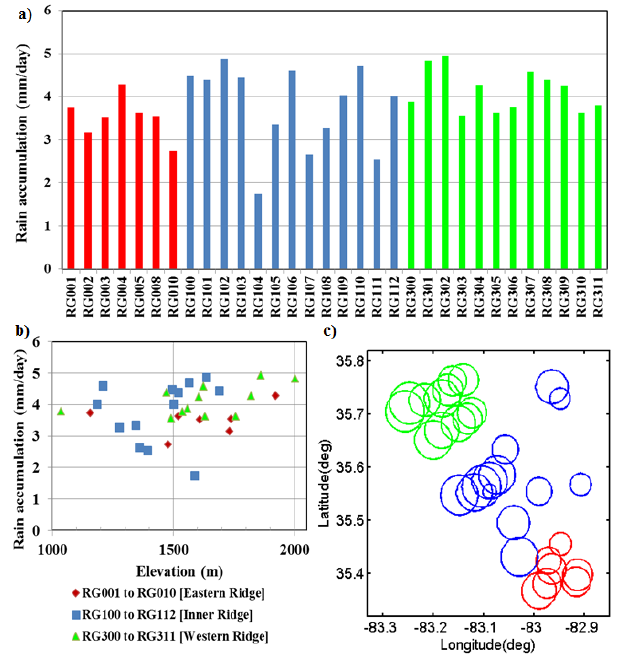
Figure 2. (a) Average rain accumulation (mmday − 1 ) for the rain- gauges deployed in the GSMRGN. Average rain accumulation as a function of (b) elevation and (c) geolocation of each raingauge with circle size indicating relative magnitude of the daily rain accumula-